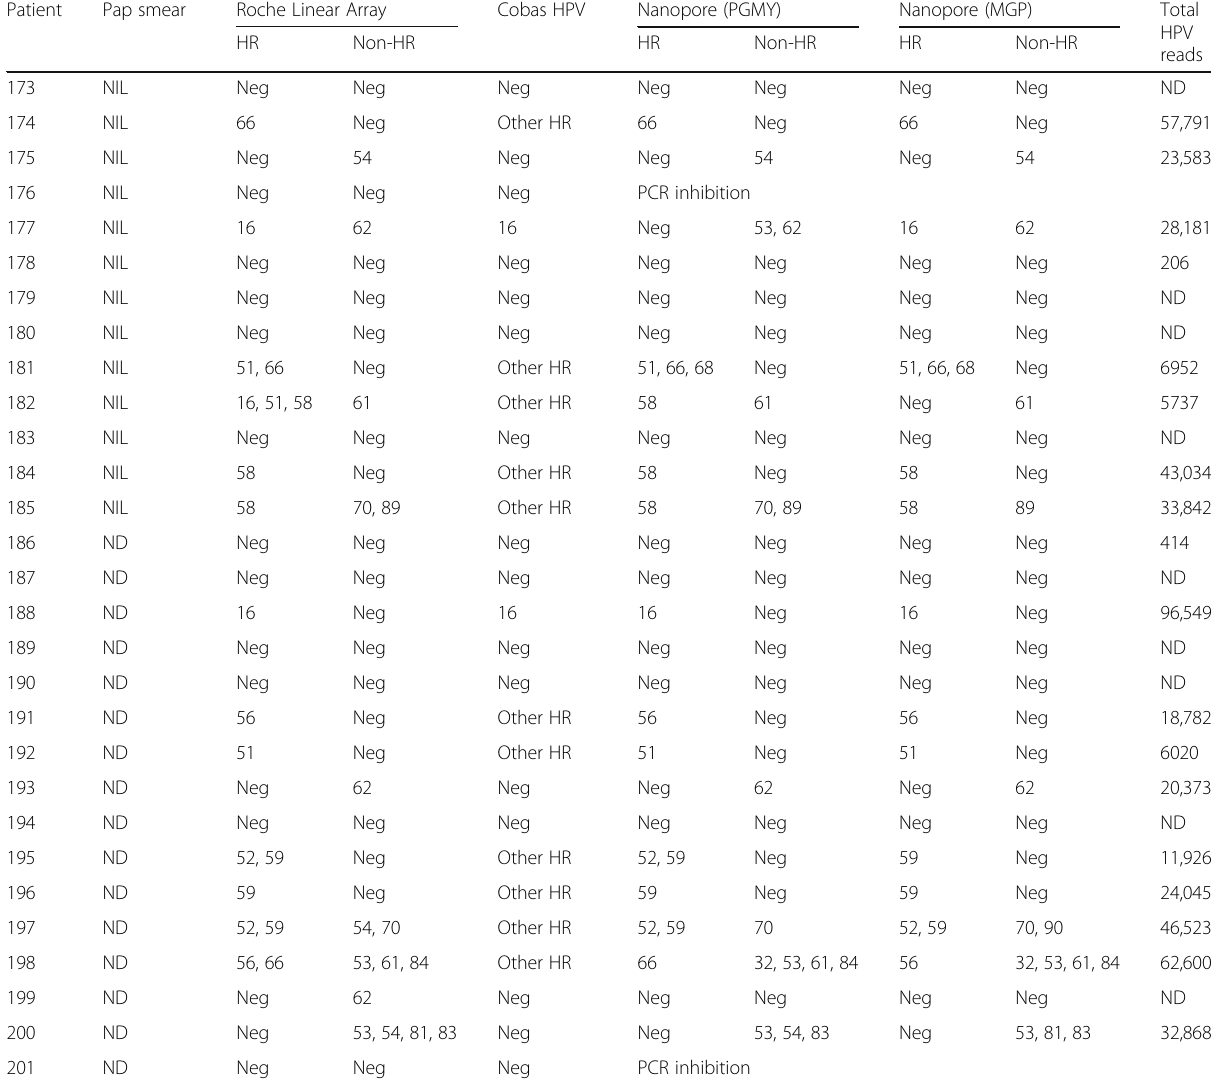
Table 1 Results of Pap smear, cobas HPV Test, Roche Linear Array HPV Genotyping Test, and Nanopore sequencing (Continued)